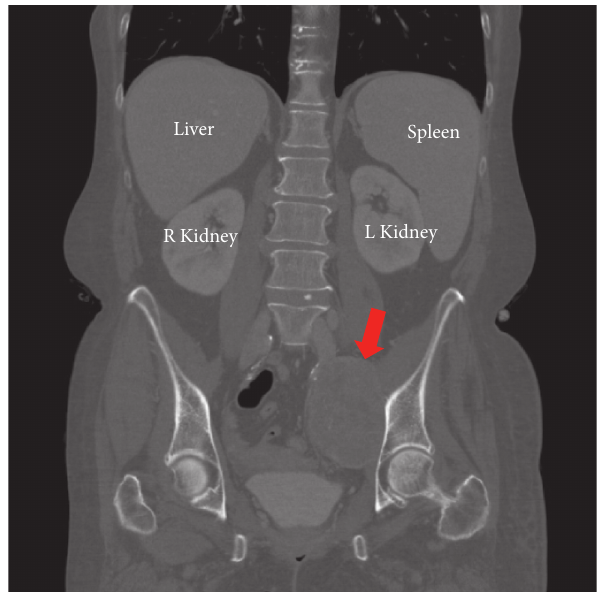
Figure 2: Computed tomography of the abdomen reveals 8.7 × 6.9 × 8.5cm mass (red arrow) in the retroperitoneal